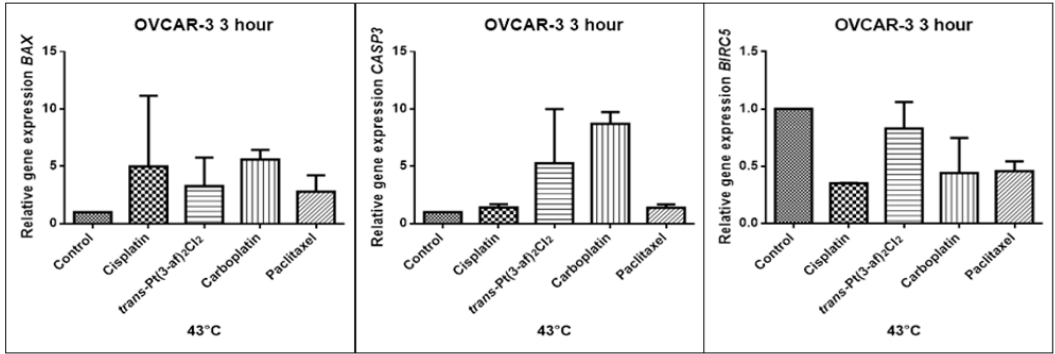
Figure 14. Level of gene expression of BAX, CASP-3, BIRC5 in ovarian cancer cells OVCAR-3. The gene expression level was presented as a relative value compared to a control equal to 1.